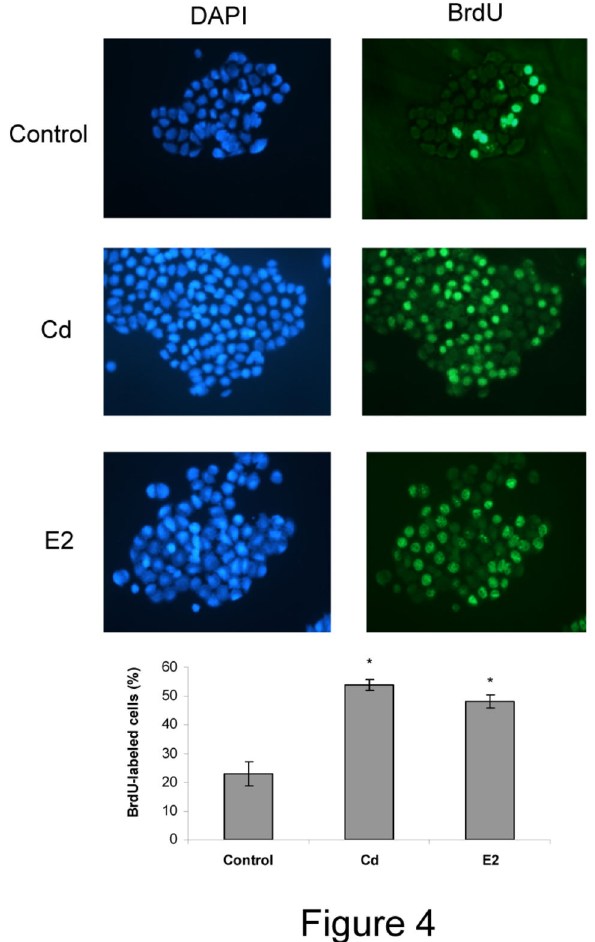
Figure 4. Cadmium stimulates GH3 cell proliferation. GH3 cells were treated with vehicle (control), 10 nM Cd or 1 nM E2 for 96 h. Cell growth was determined by ICC measuring 3 h-BrdU incorporation. Cell nuclei were stained by DAPI. Pictures are representative of three independent experiments performed in triplicate. Bars represent the mean ± SE of BrdU-labeling index expressed as positive BrdU cells / total cell number x 100. ANOVA followed by Tukey-Kramer’s test, *p<0.05 vs. control (N=3).